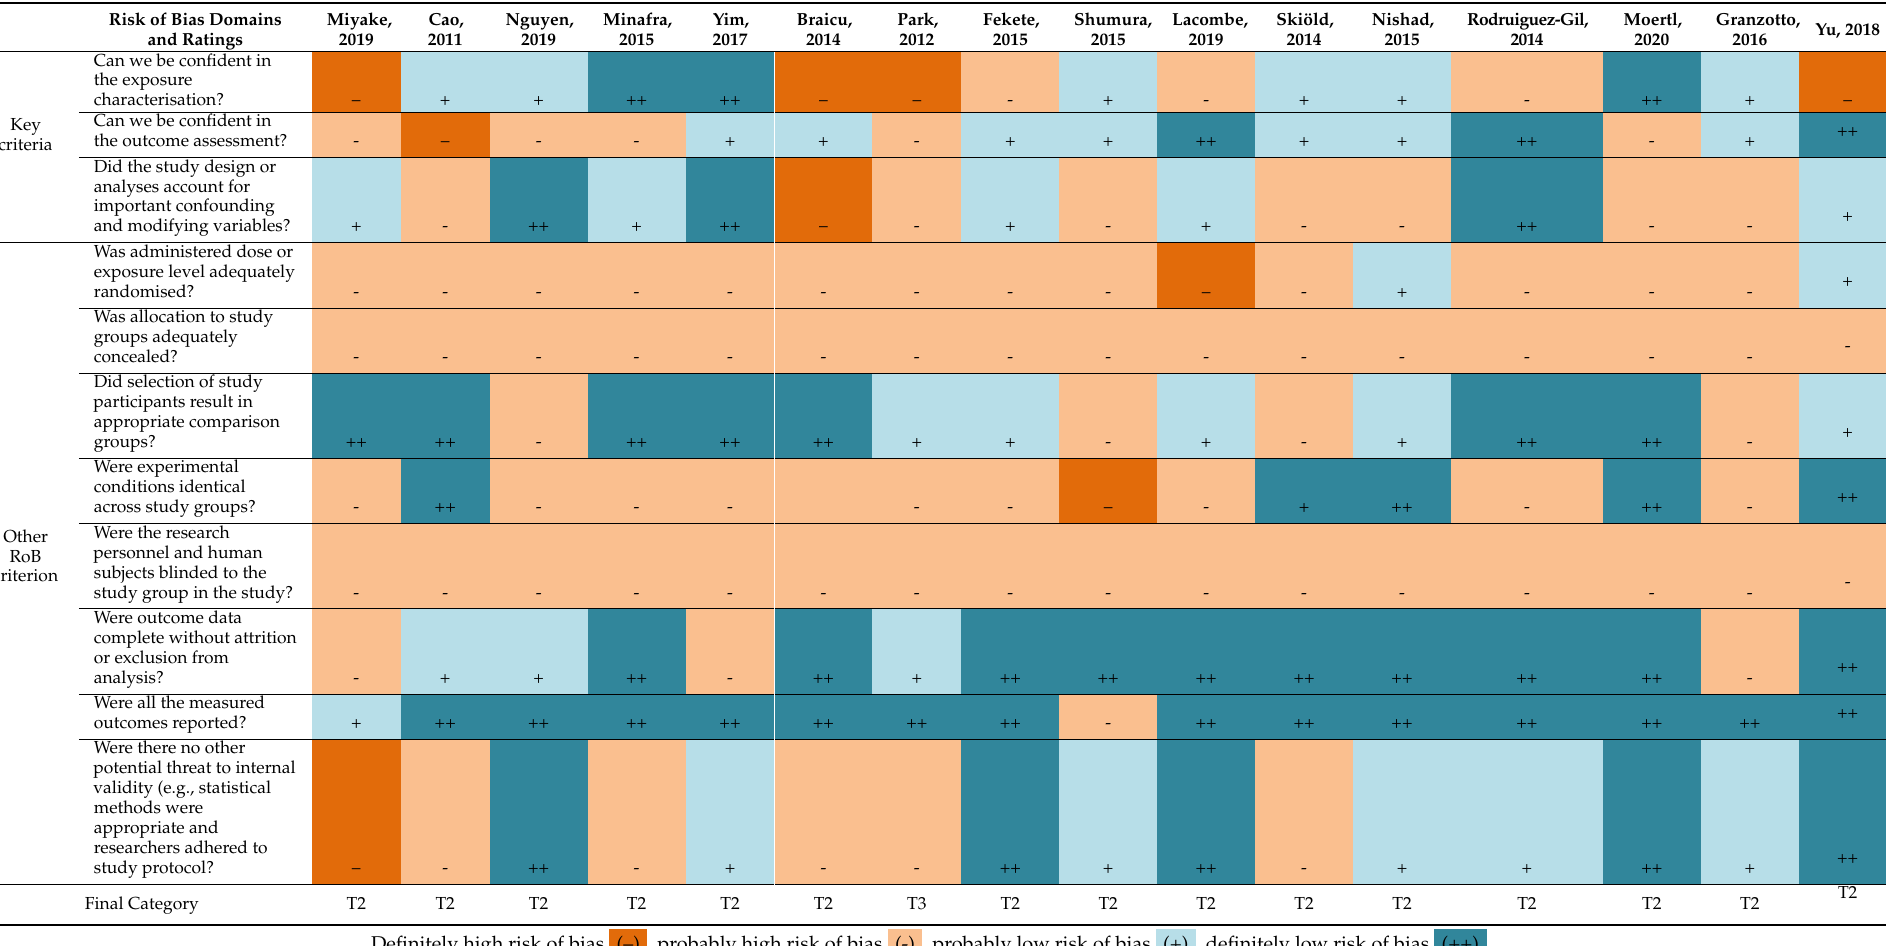
Table 2. Accessing risk of bias for studies that included proteins other than repair